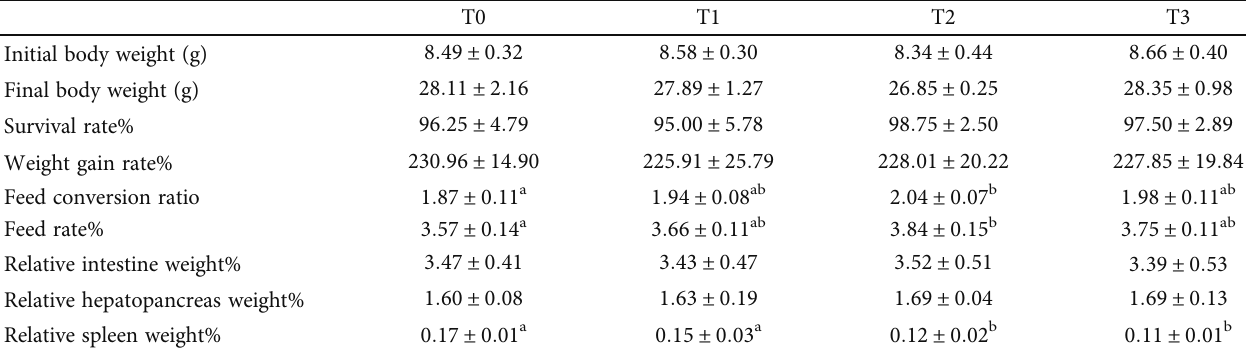
Table 4: Survival and growth performance of grass carp fed semipuri fi ed diets ( means ± SD , n = 4 ). T0